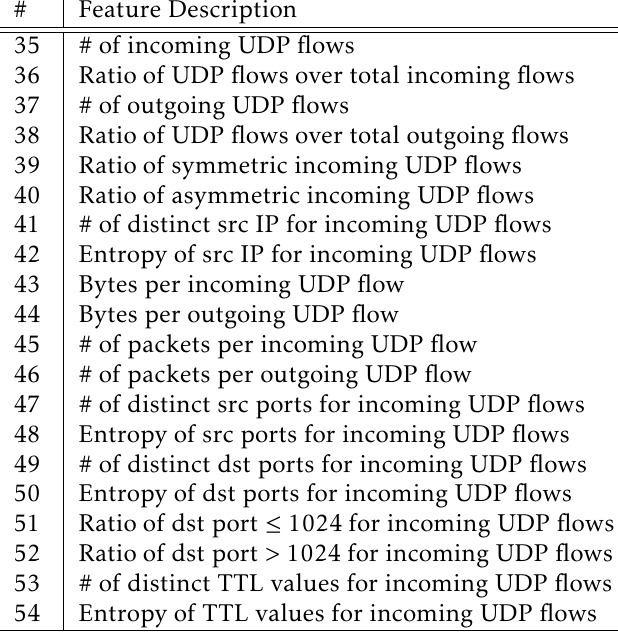
Table 3. Features extracted for UDP flows